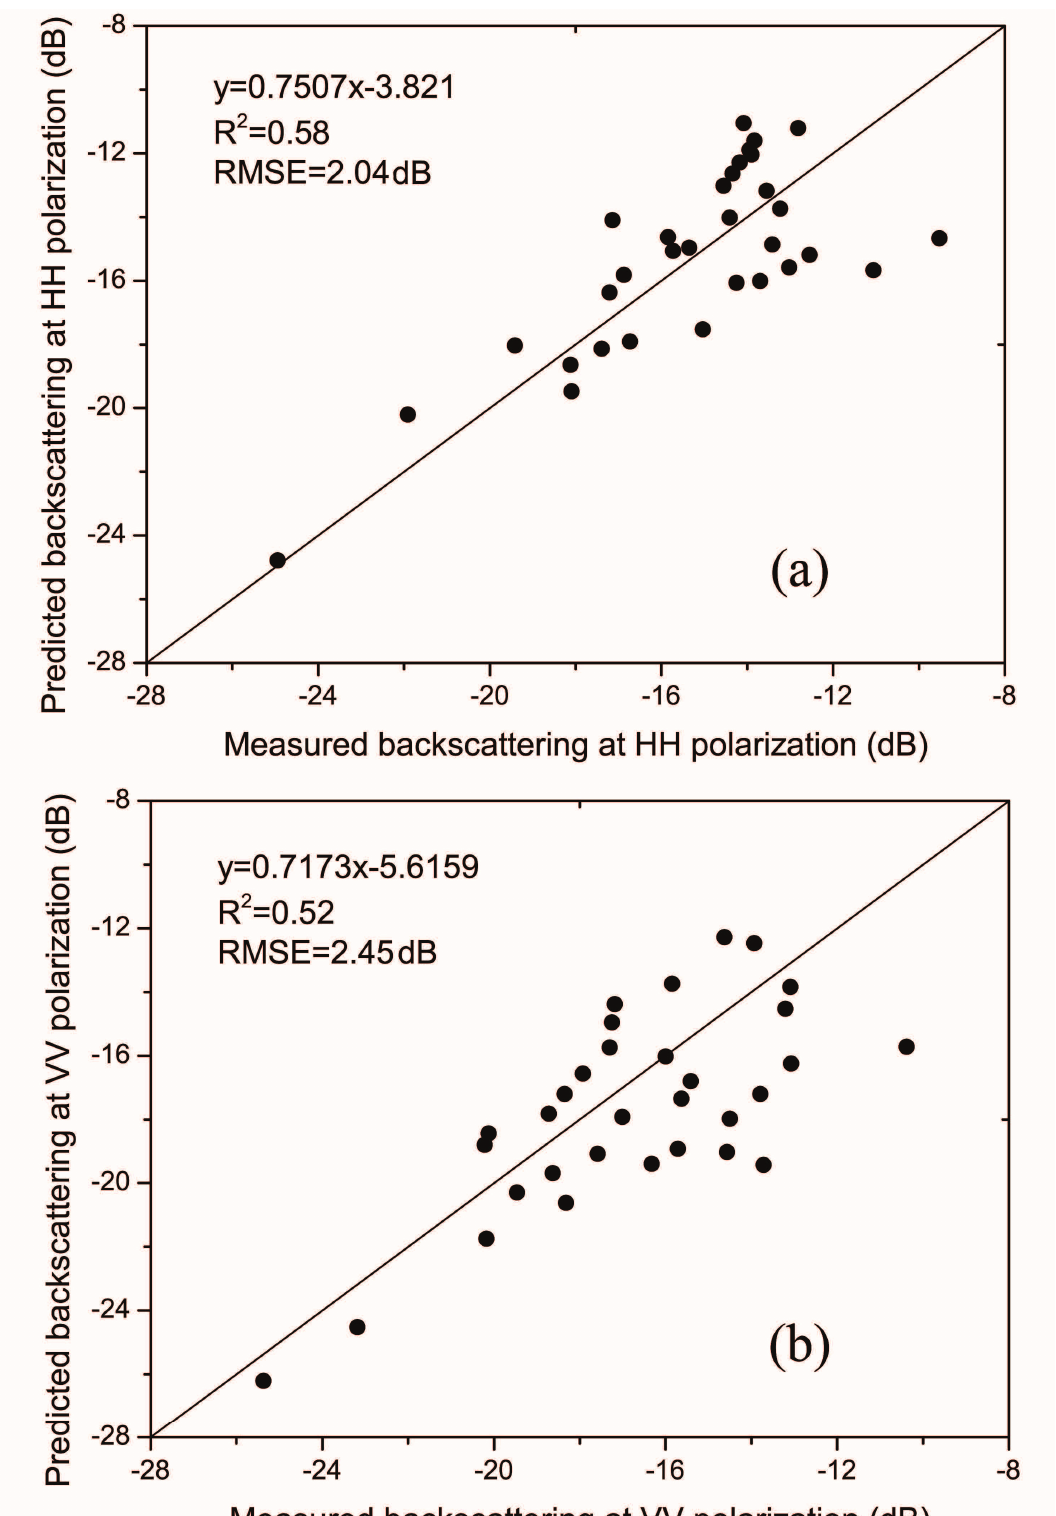
Figure 2. Scatterplot illustrating the relationship between the measured backscattering from images and predicted backscattering values from the vegetation backscattering model described in Section 3.2.1 for ( a ) HH polarization and ( b ) VV